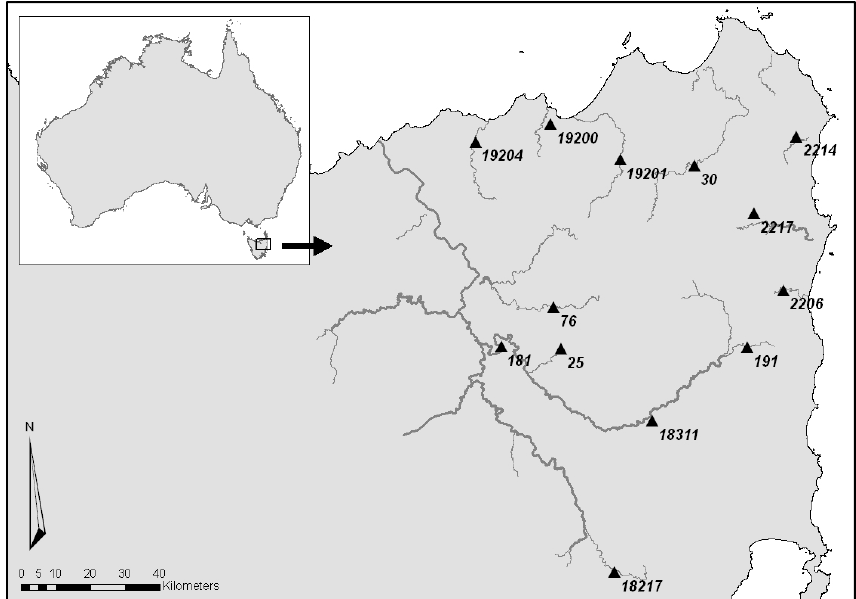
Figure 1. Location of major rivers and stream-flow stations in North-Eastern Tasmania used in this study. State Government stream-gauge codes are used to identify